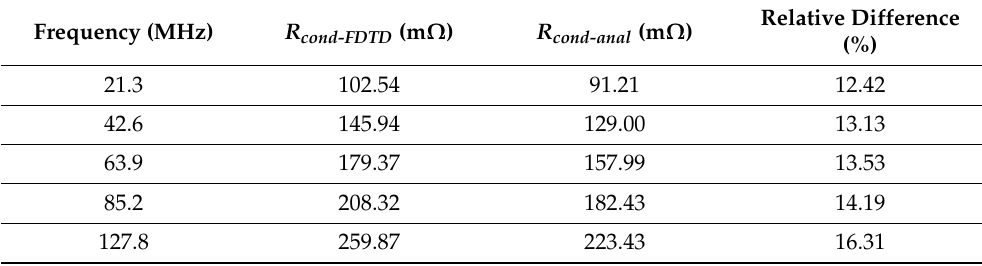
Table 8. Coil conductor resistance estimation for different frequencies ( n = 4-segment loop). FDTD and analytical calculation results.